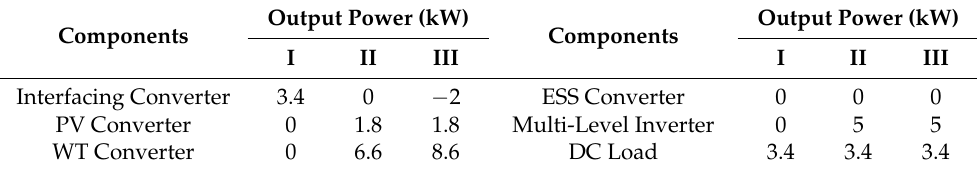
Table 4. Output power of each power conversion devices in mode 4.